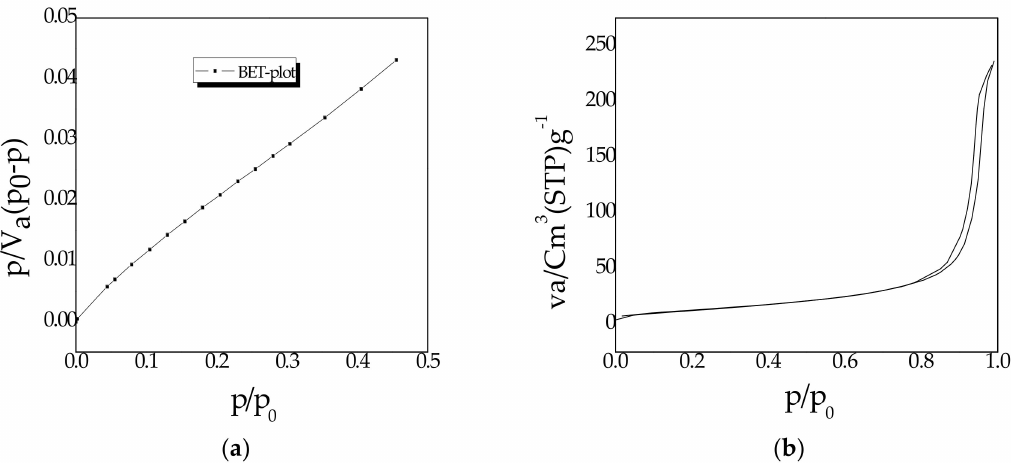
Figure 2. Adsorption / desorption isotherms of the catalyst by nitrogen physisorption: ( a ) curve of the BET isotherm; ( b ) desorption / adsorption curve for surface area